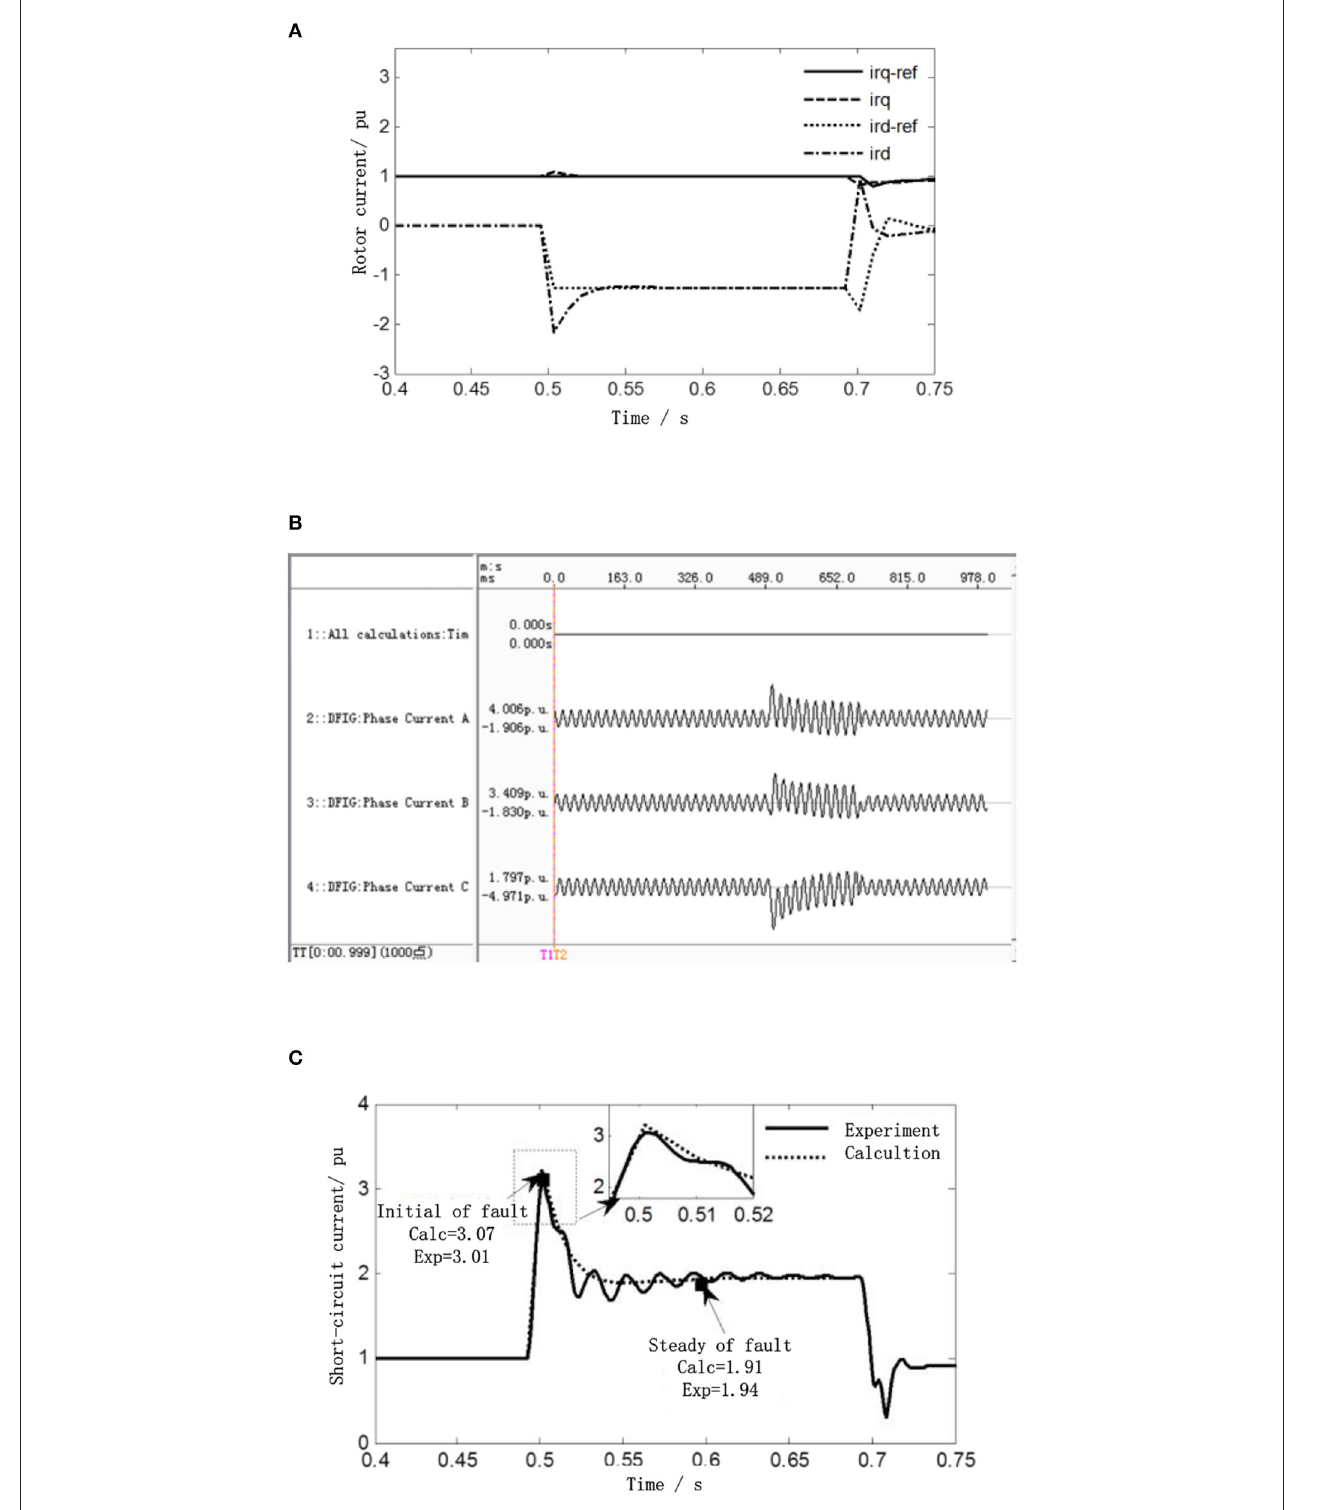
FIGURE 6 | Comparison figure between the calculation result and experimental result of DFIG three-phase short circuit at bus B. (A) Comparison of the rotor current control reference value and actual rotor value. (B) Experimental result of short-circuit current of three-phase short-circuit DFIG at bus B under rated conditions. (C) Comparison of the calculation result and experimental result of root mean square (RMS) three-phase short circuit at bus B.